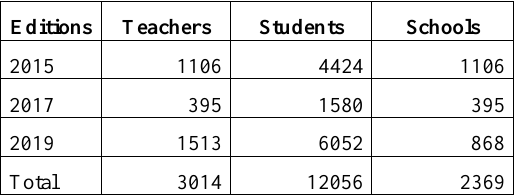
Table 1. Students and Teachers Participation in